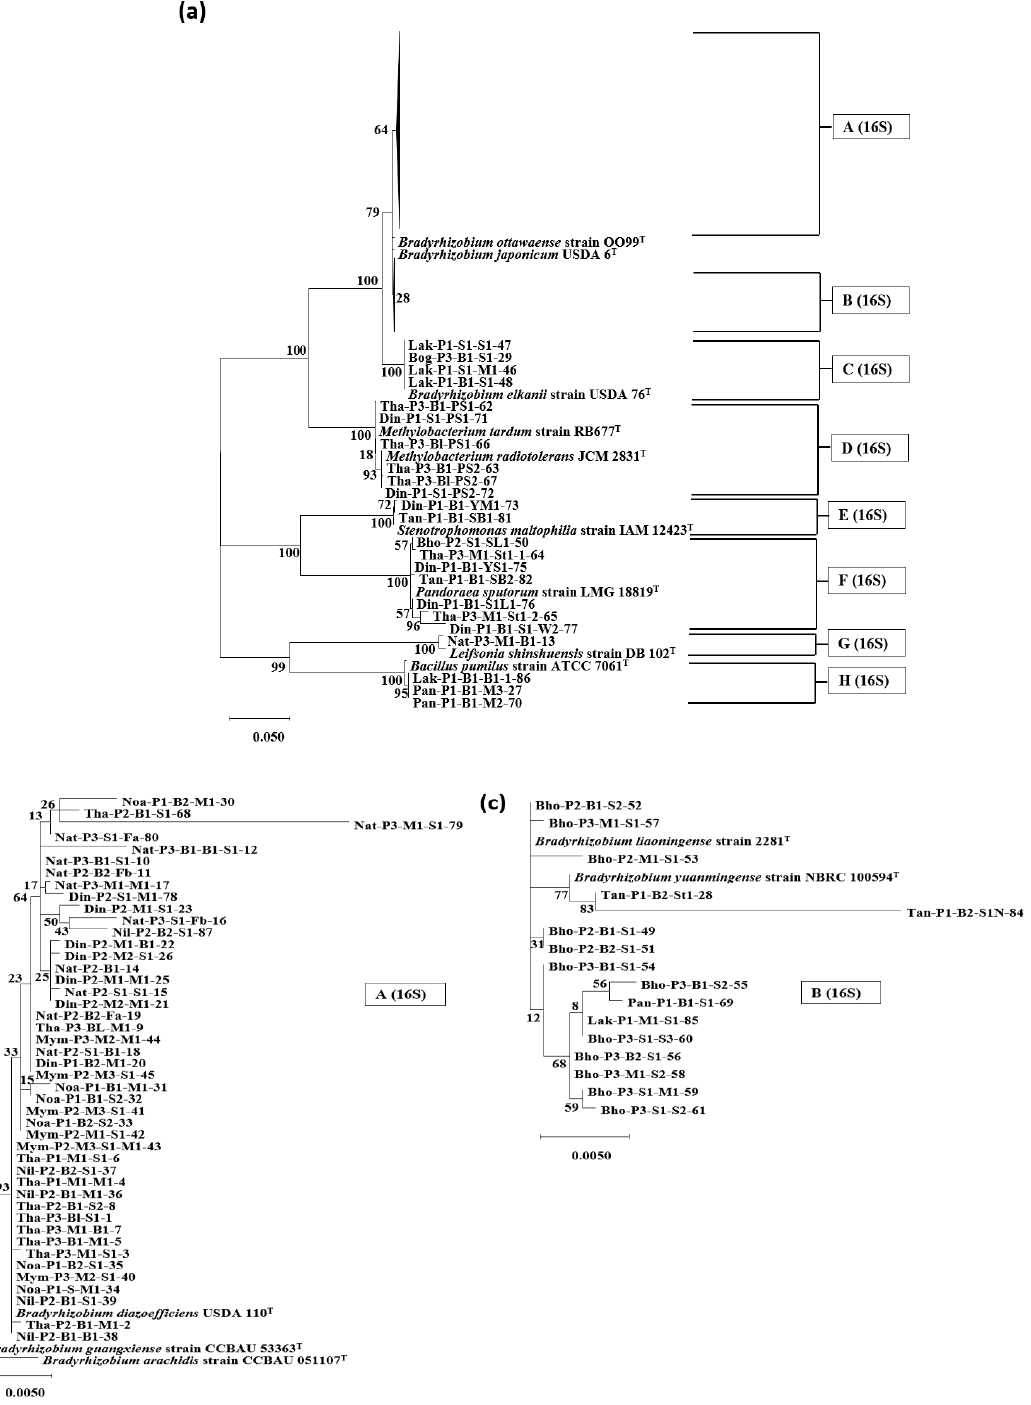
Figure 2. Phylogenetic analysis of the 16S rRNA gene of 84 isolated bacteria with reference strains. The percentage of trees in which the associated taxa clustered together after 1000 Bootstrap replications is shown next to the branch points. ( a ) The main tree with two compressed sub-trees is shown with ( b , c ) the respective sub-trees.